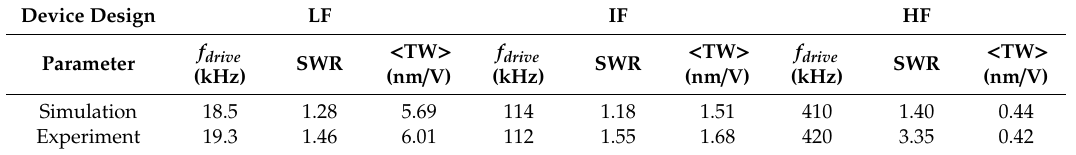
Figure 7. TW magnitude (per unit of applied voltage) and phase for di ff erent devices along the bridge length. Measurement (solid lines) and calculation (dotted line) in ( a ) LF, ( b ) IF and ( c ) HF devices. The dashed vertical lines indicate a centred 50% of length. Table 5. Simulated and experimental figures of merit of the generated TW.